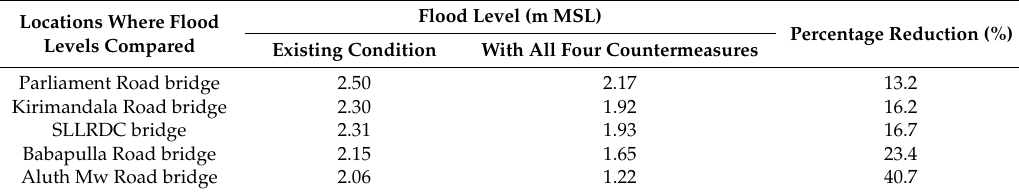
Table 10. Comparison of flood levels for 2010 November